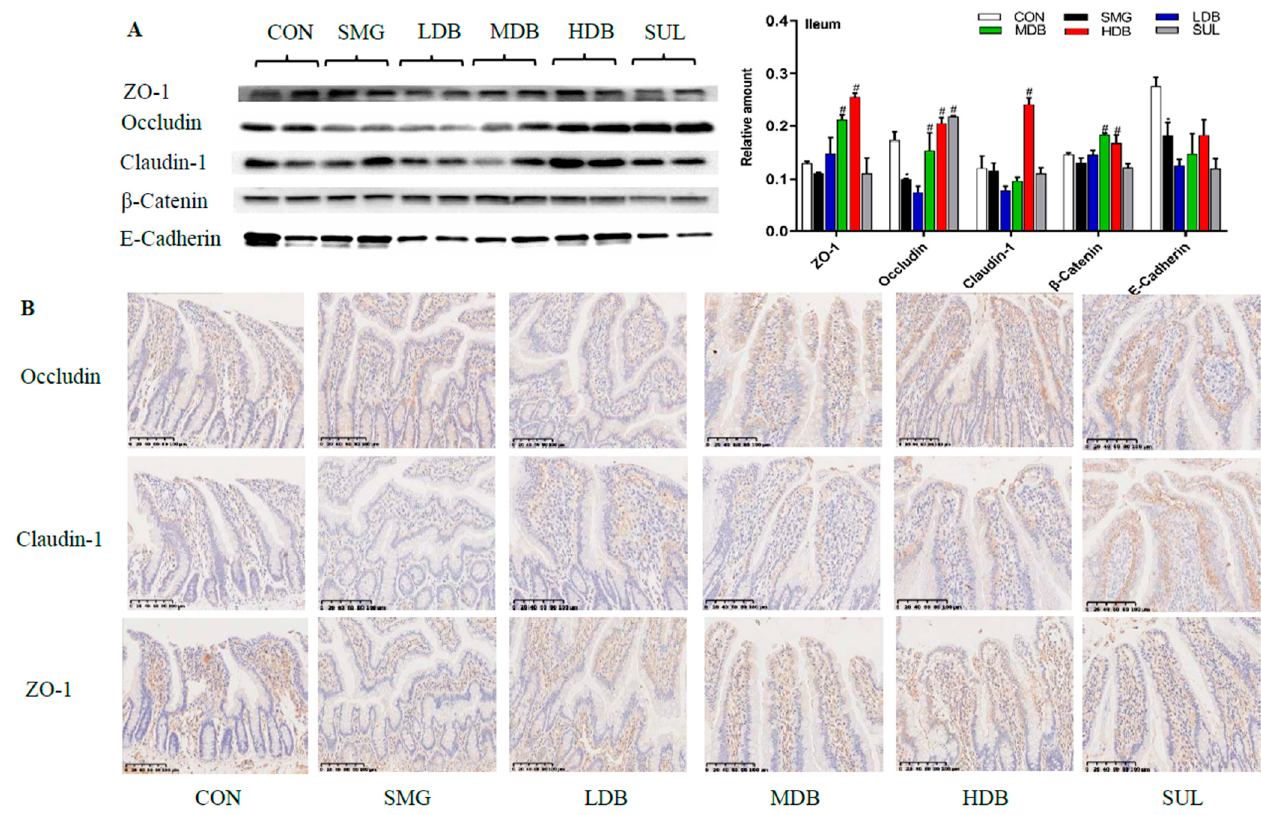
Figure 2. DB protected the intestine epithelial barrier (IEB) injury via increasing the expression of TJ and AJ proteins in ileum of SMG rat. ( A ) the expression of ZO-1, occludin, claudin-1, β -catenin and E-cadherin determined by Western-blot ( n = 9). ( B ) the expression of occludin, claudin-1and ZO-1 detected by immunohistochemistry (brown granules represent TJ proteins) in SMG rat ileum tissues (ruler scale of 100 µ m, n = 9). Note: * p < 0.05, compared with CON group. # p < 0.05, compared with SMG group. The relative expression levels of proteins were expressed as the ratio of gray value of the target band to that of total proteins in the same sample. The total protein gel was shown in Supplementary Figure